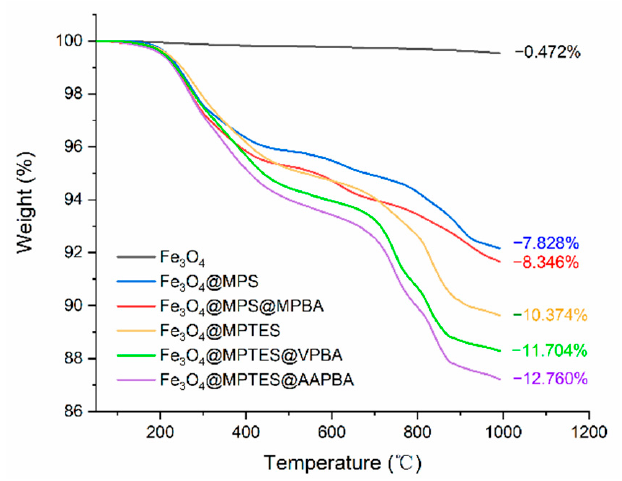
Figure 5. Thermogravimetric analysis curves of phenylboronic-acid-modified magnetic nanoparticles.